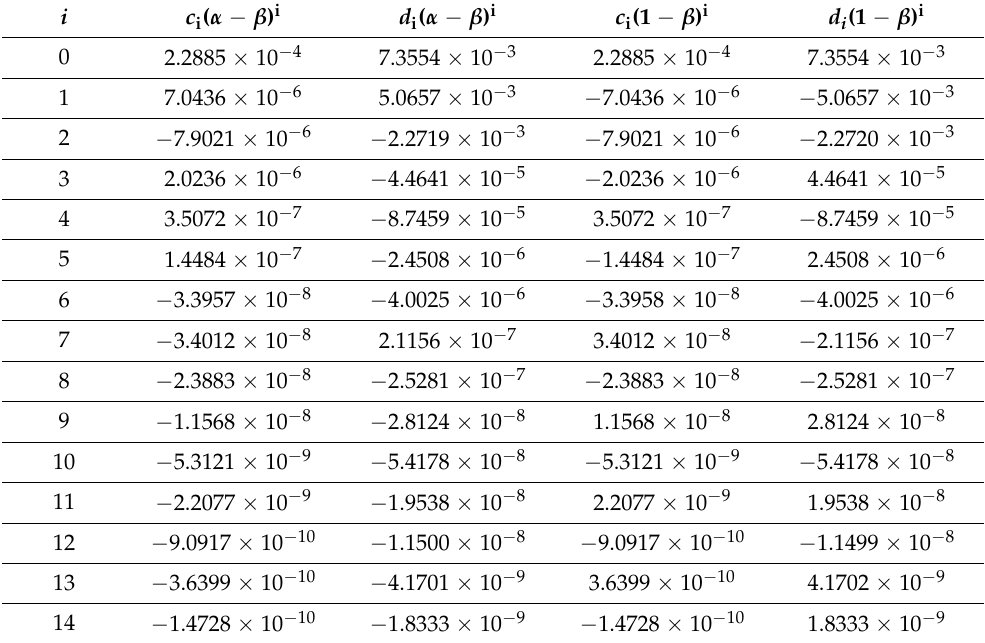
Table 4. The numerical calculation results of c i ( α − β ) i , d i ( α − β ) i , c i (1 − β ) i and d i (1 − β ) i , when q = 1.725 × 10 − 6